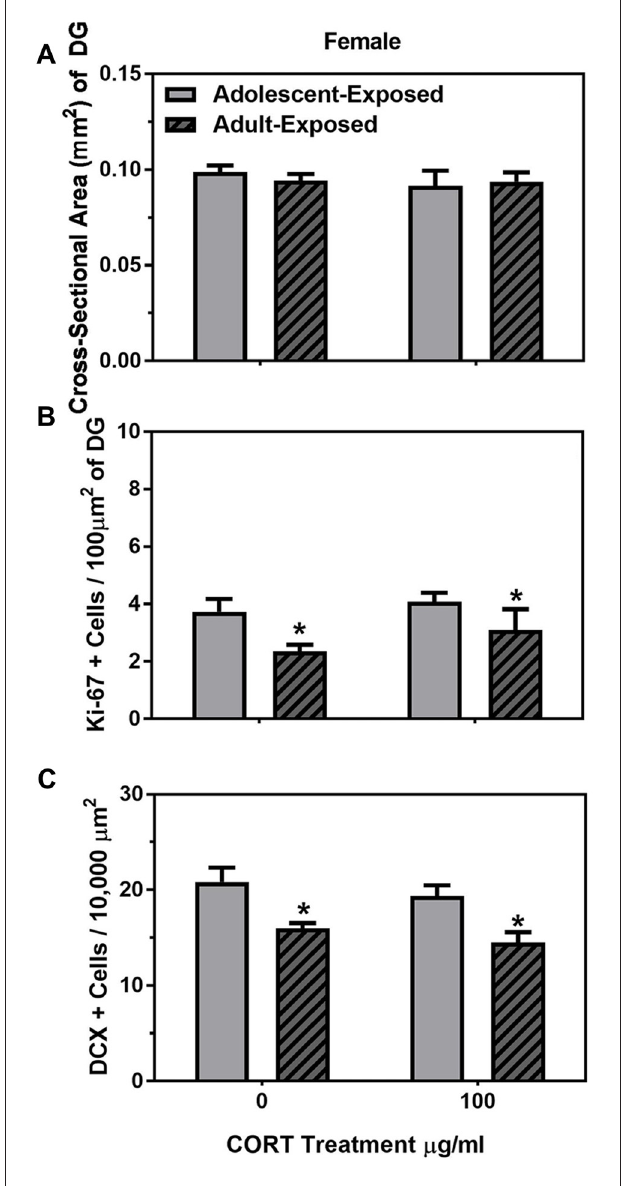
FIGURE 4 | Mean ( ± SEM) cross-sectional area (mm 2 ) of the DG (A) number of Ki-67-positive cells per 100 µ m 2 of DG (B) and number of DCX-positive cells per 10,000 µ m 2 (C) in female mice exposed to either 0 or 100 µ g/ml of CORT during adolescence (light gray bars) or adulthood (dark gray bars with hash marks). Asterisks indicate a significant difference between the adolescent-exposed and adult-exposed animals.